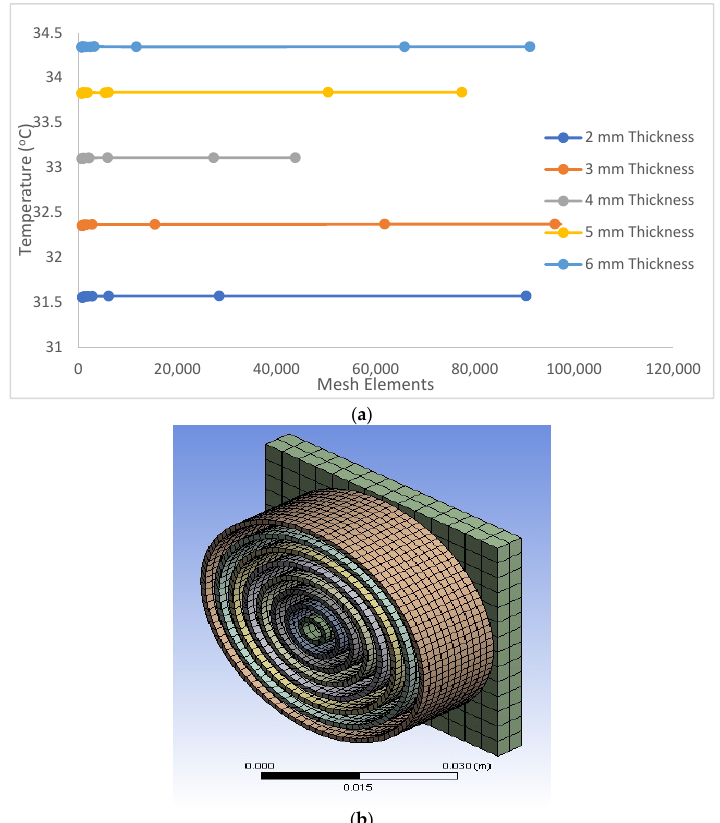
Figure 2. ( a ) Mesh dependency study of the present model. ( b ) Meshed with 108,813 nodes and 27,313 elements.